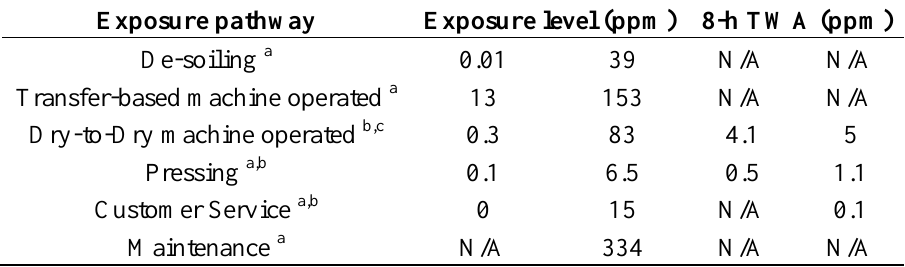
Table 1. PCE dry cleaning exposure pathways and